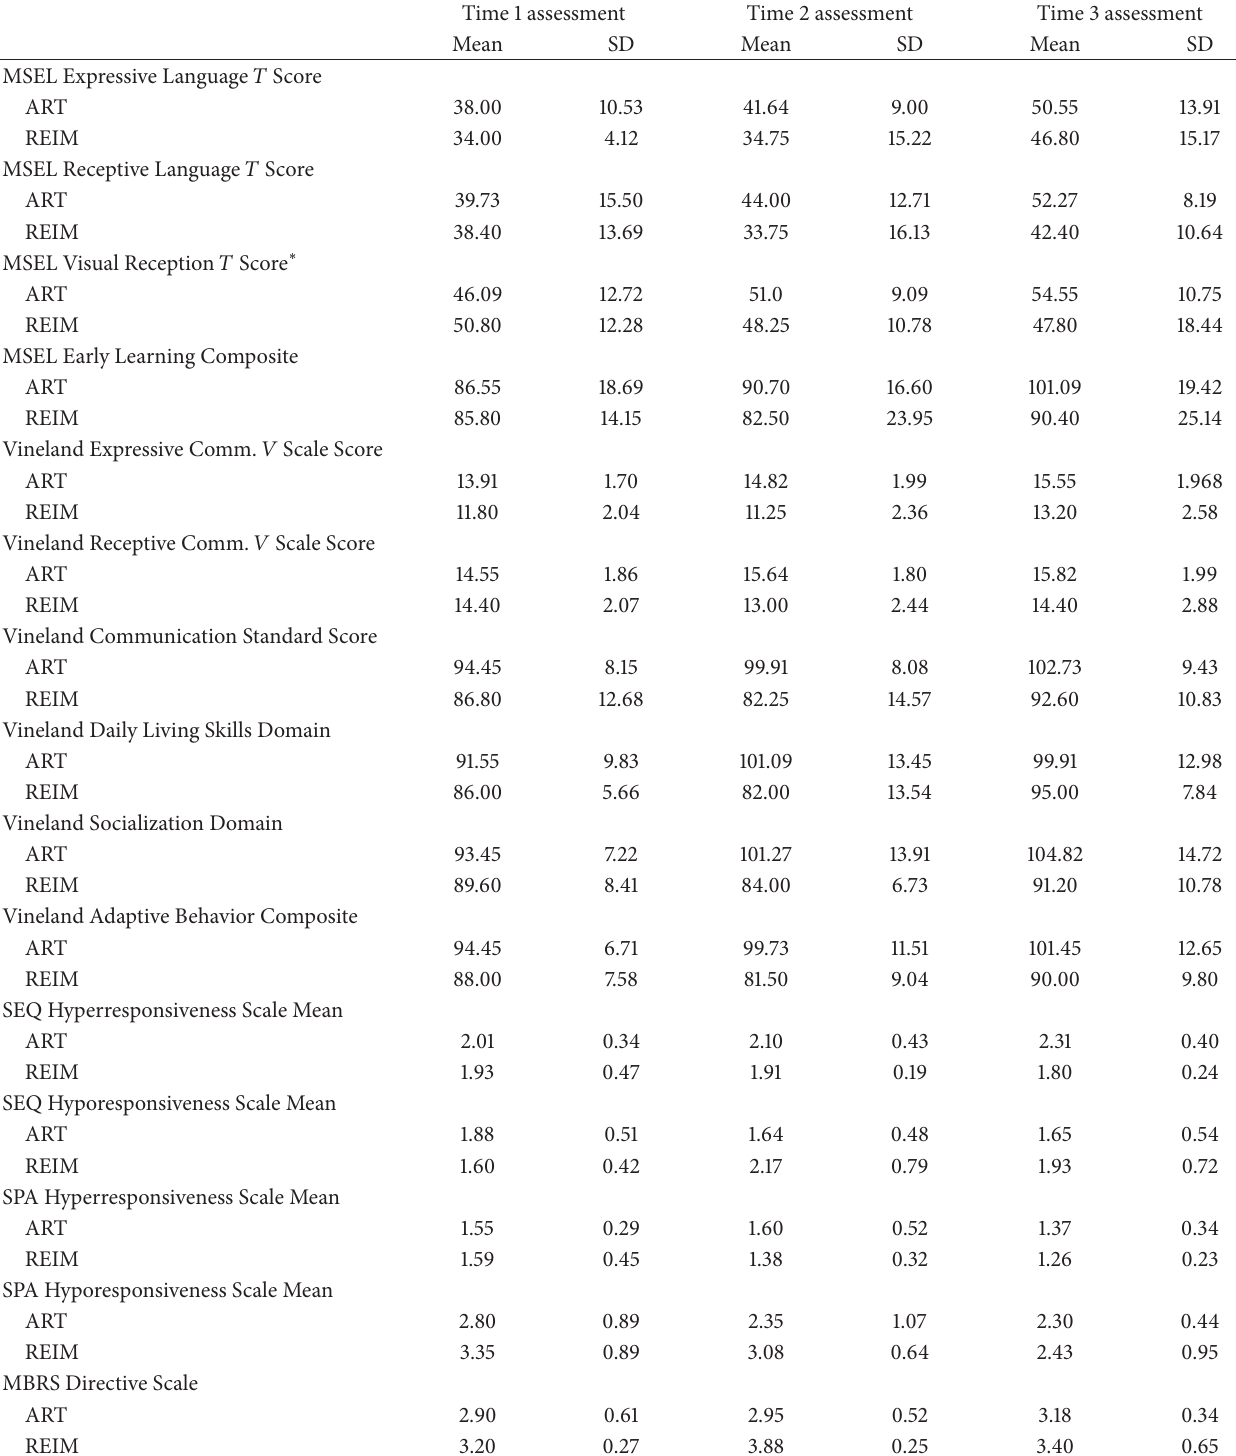
Table 3: Means and standard deviations (SD) for all variables: ART and REIM